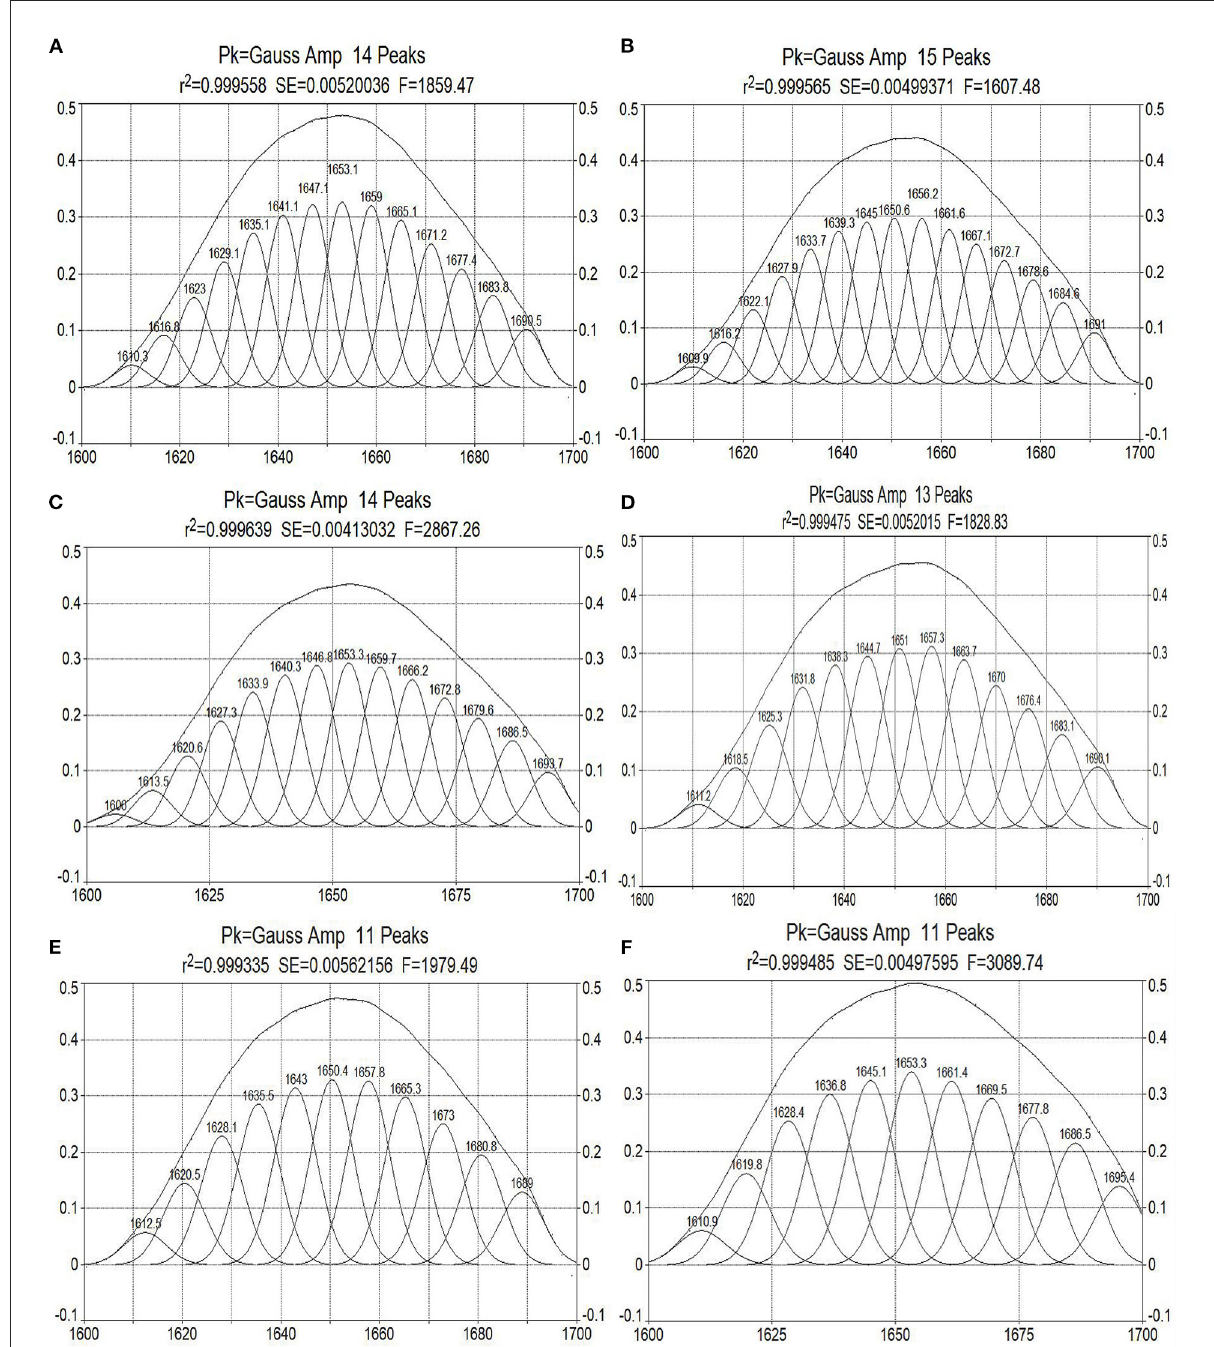
FIGURE7 Curve-fitted results of amide I bands of E. coli treated by cinnamaldehyde with different concentration [ (A–F) are Blank, 0.0625, 0.125, 0.25, 0.5, and 1.0 µ L/mL of cinnamaldehyde fumigation].